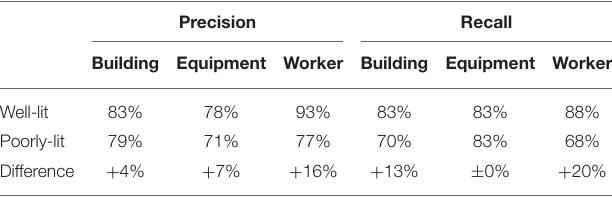
TABLE 3 | Performance of the best model in detecting well-lit and poorly lit objects.